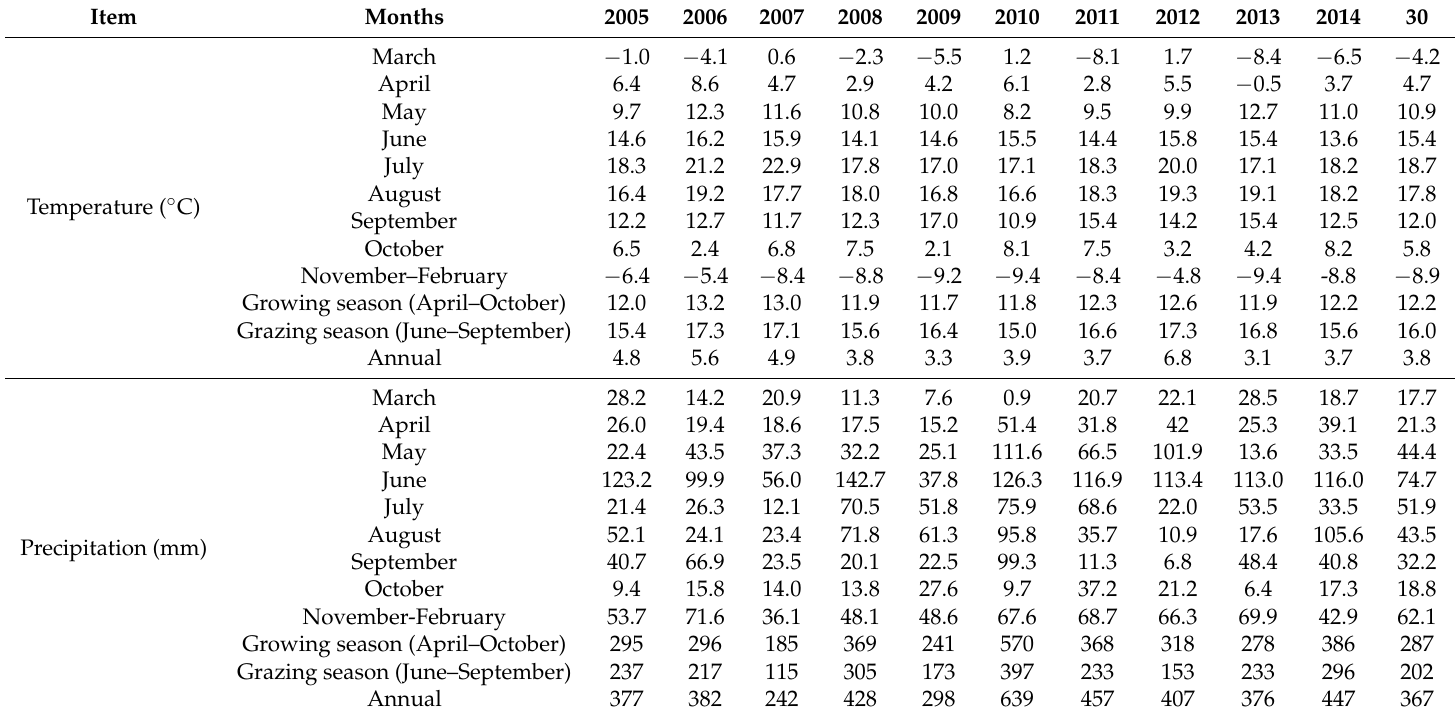
Table 2. Mean annual temperature and precipitation received during the experimental period in 2005–2014 and a long-term average (30 years) at the experimental site near Swift Current, SK,